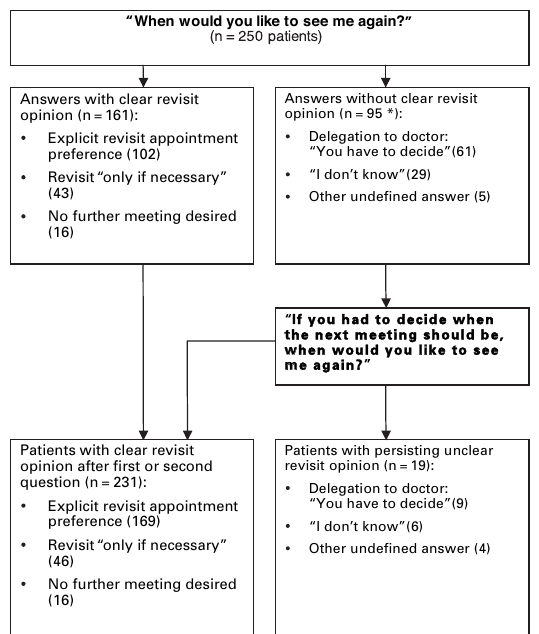
Flow-chart of two-step process to report patients’ reactions to “When would you like to see me again?” Note: only patients giving unclear answers were addressed twice. Physicians’ answers are not contained in the flow chart. * To the first ques- tion, 6 patients gave answers in more than one